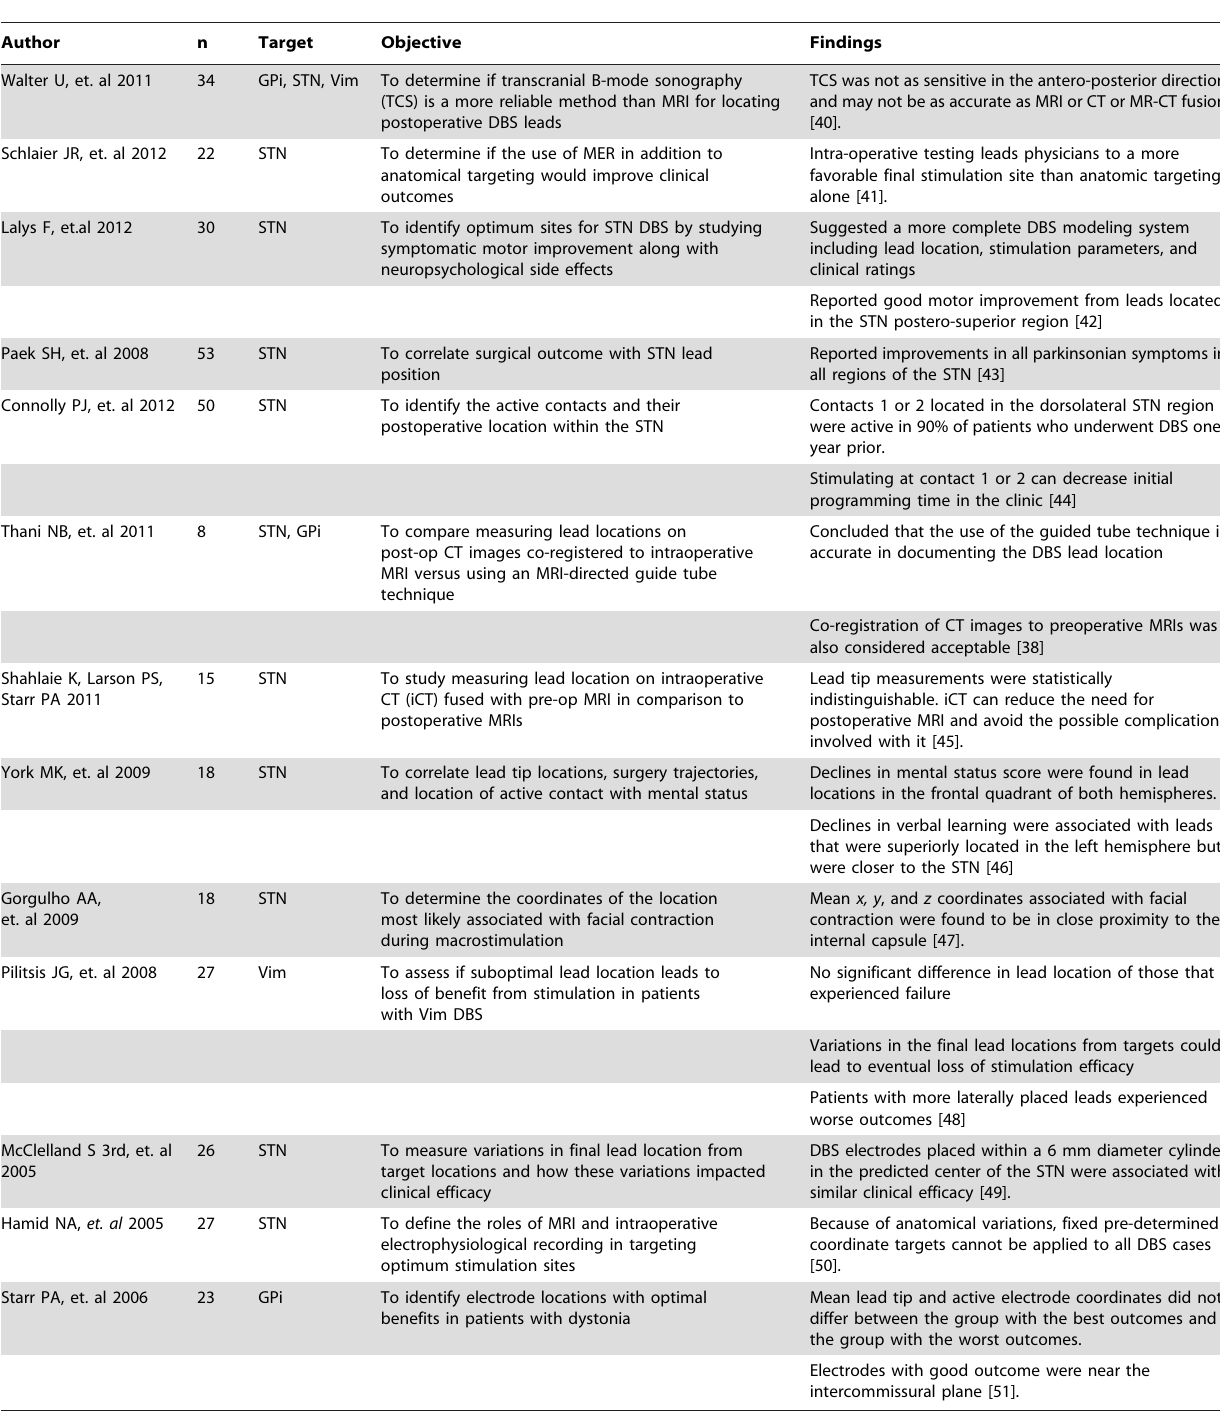
Table 1. A Summary of Studies Approaching DBS Lead Location and